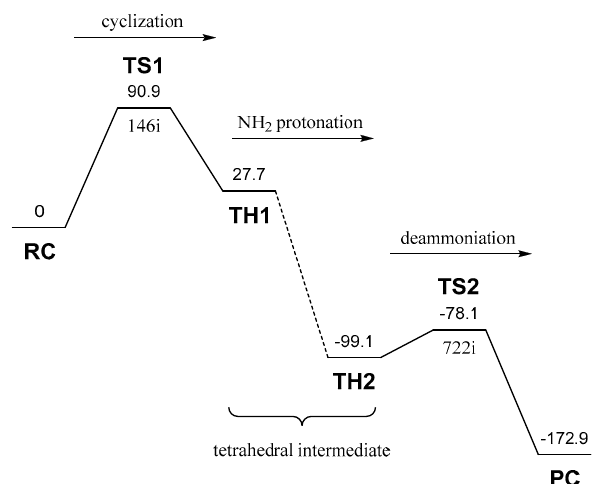
Figure 2. Energy profile in water. RC: reactant complex; TS: transition state; TH: tetrahedral intermediate; PC: product complex. The relative energies with respect to RC are shown in kJ · mol − 1 . The imaginary frequencies for the two transition states are also shown.